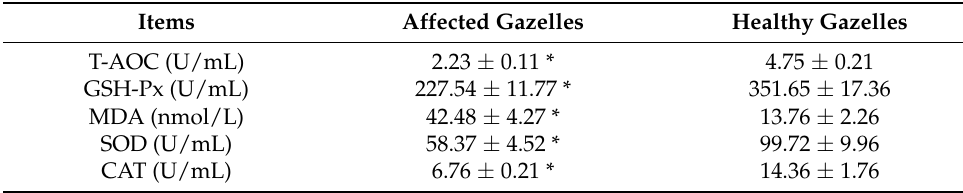
Table 5. The antioxidant levels in serum in gazelles. Items Affected Gazelles Healthy Gazelles